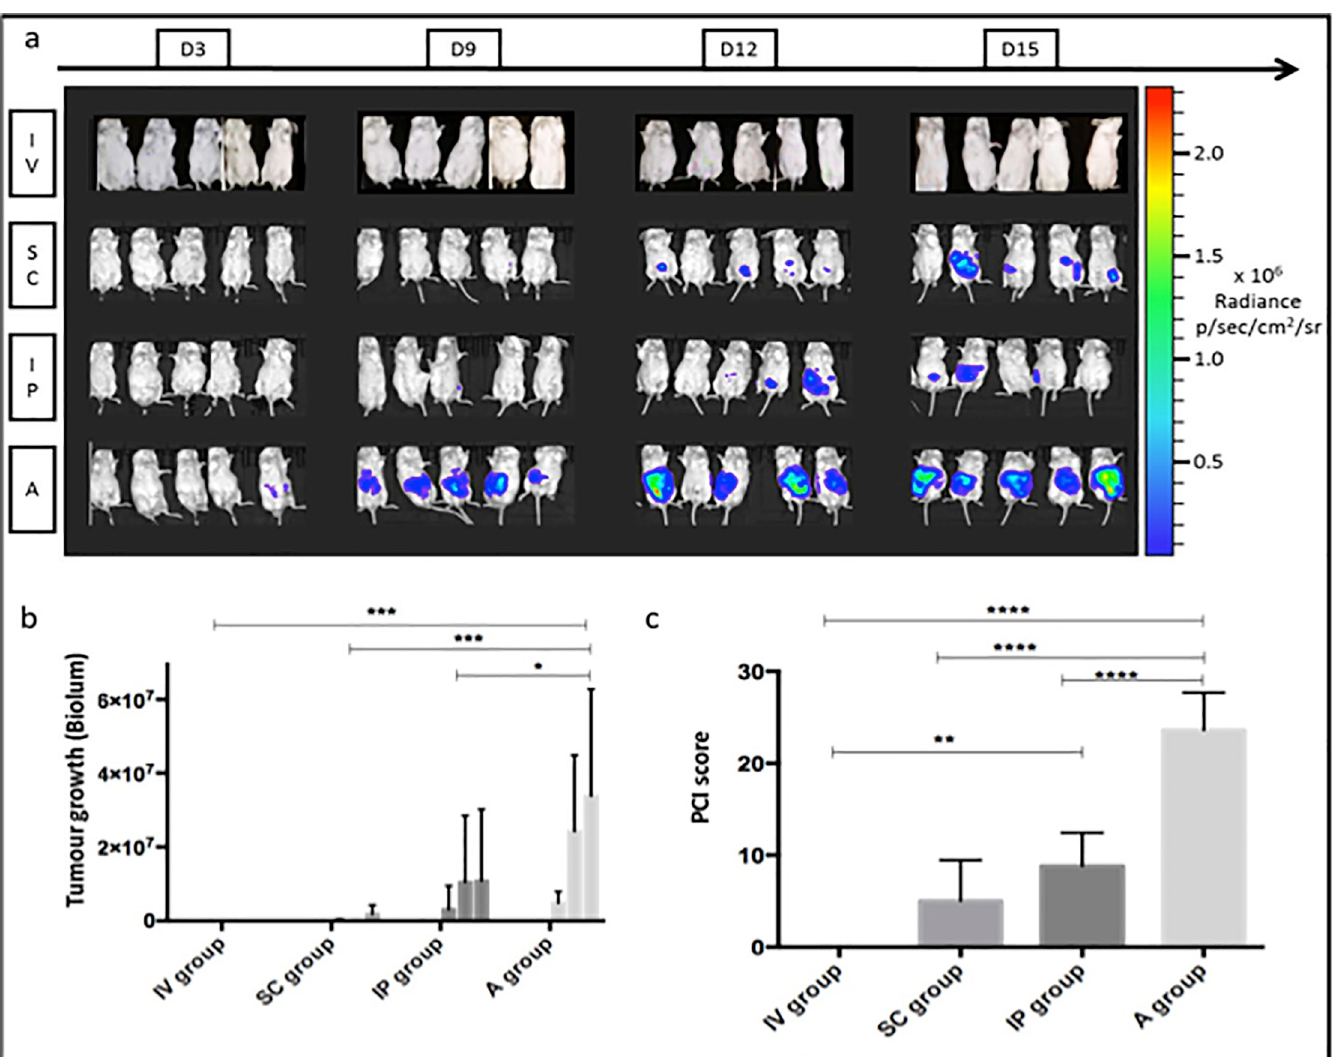
Fig 1. In vivo quantification of tumor growth by bioluminescence tracking of luciferase expressing CT-26 cells over 15 days. (A) Microphotographs of anesthetized mice for each group inside the bioluminescent imaging box. (B) Tumor growth evaluation based on bioluminescence measurements for the four groups (IV, SC, IP, A) at day 3, day 9, day 12 and day 15 (low values are not always visible on the graph). (C) PCI score at day 15 post-grafting. In summary, the mice having undergone laparotomy surgery (group A: intraperitoneal cell injection after peritoneum aggression) present an extensive tumoral growth with the highest peritoneal carcinomatosis index (PCI). Furthermore, statistically significant differences are observed between the four groups. n = 5 for each group, mean +- SD. � for p value < 0.05, �� < 0.01, ��� < 0.001 and ���� <